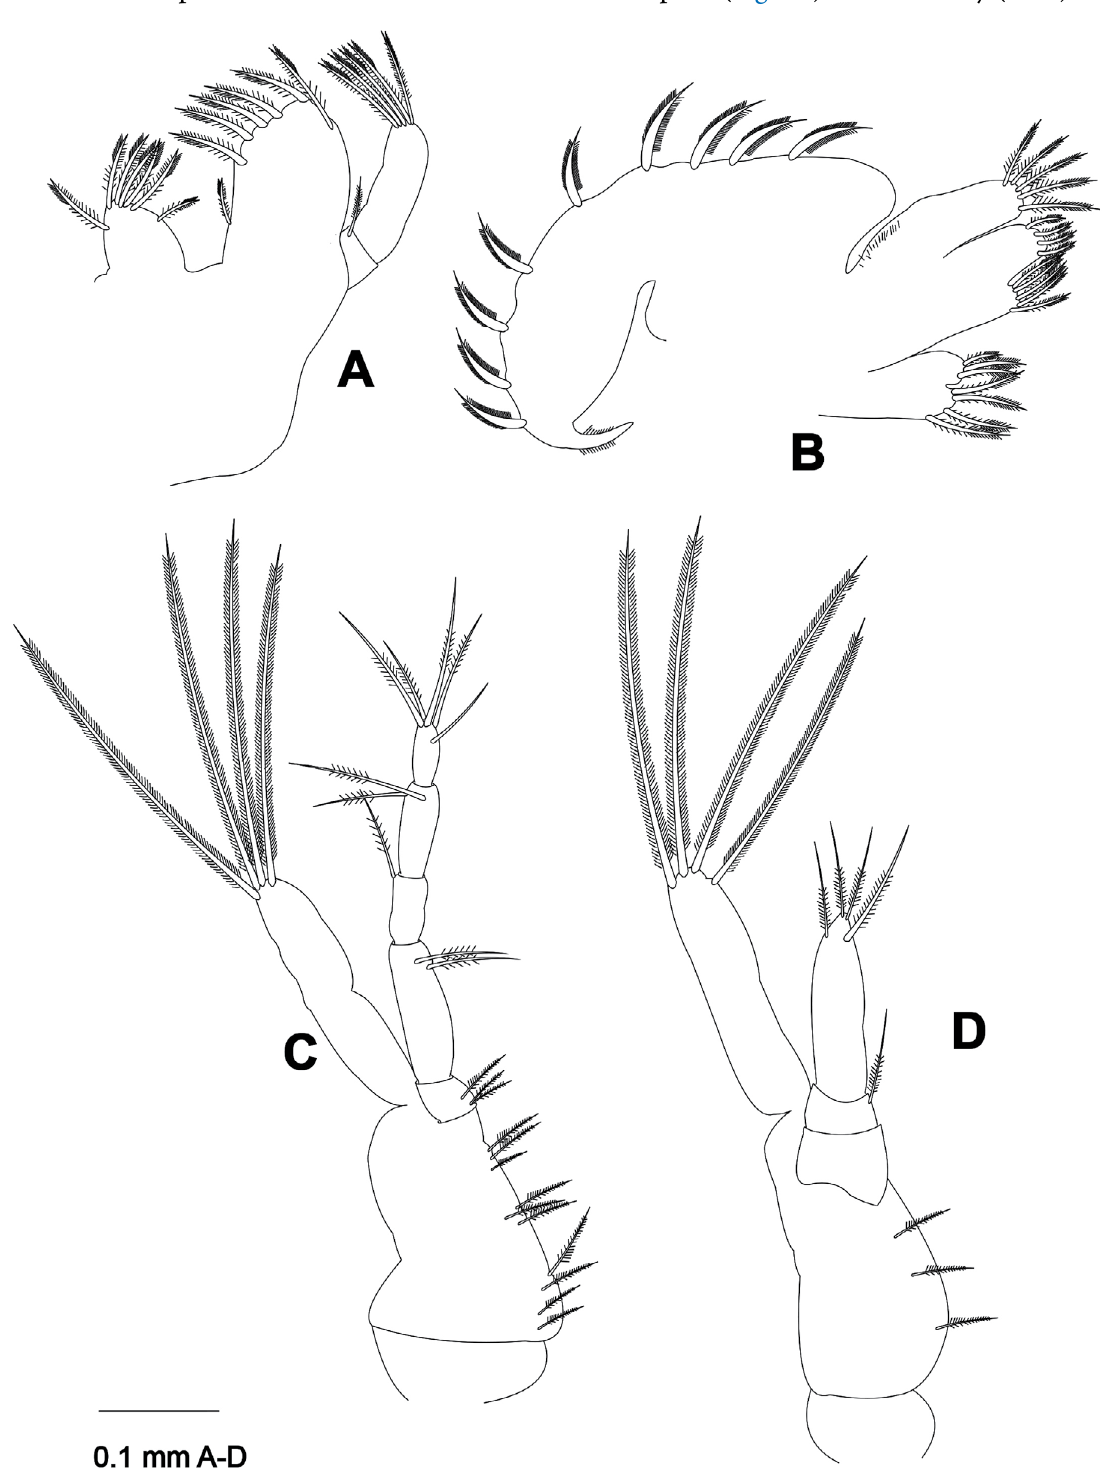
Figure 2. Libinia rhomboidea first zoea. ( A ) Maxillule; ( B ) maxilla; ( C ) first maxilliped; ( D ) second